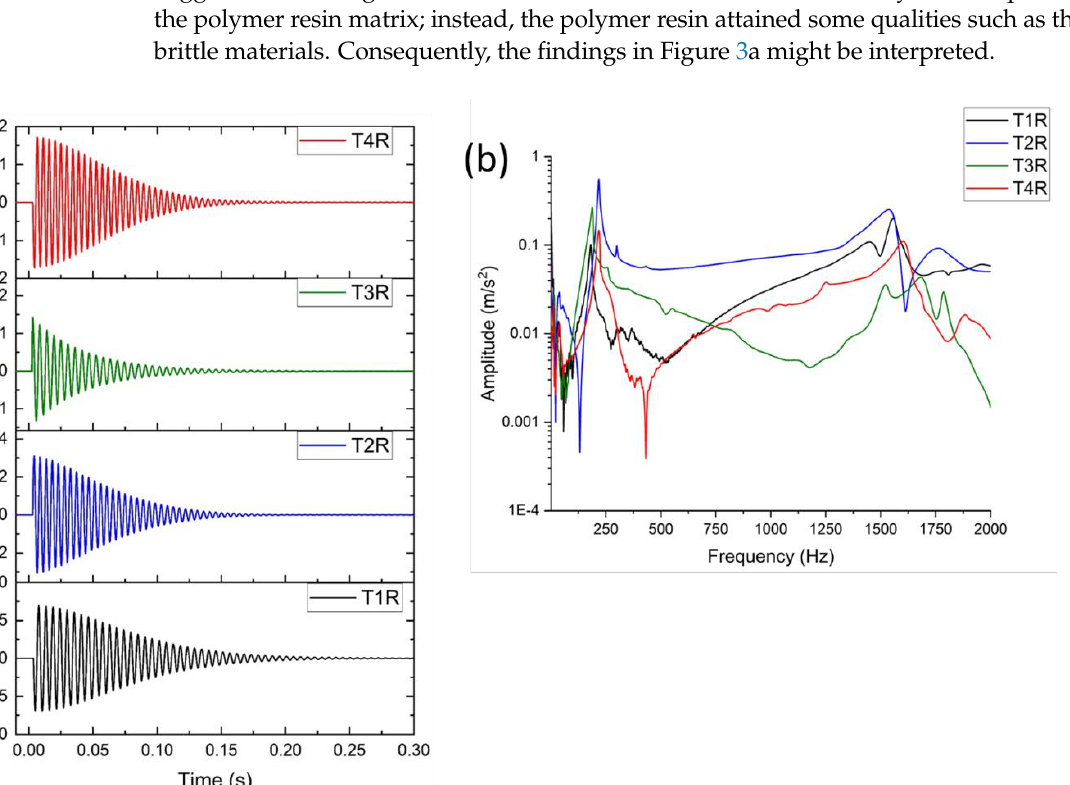
Figure 5. The damping ratio response of the samples without a coat .